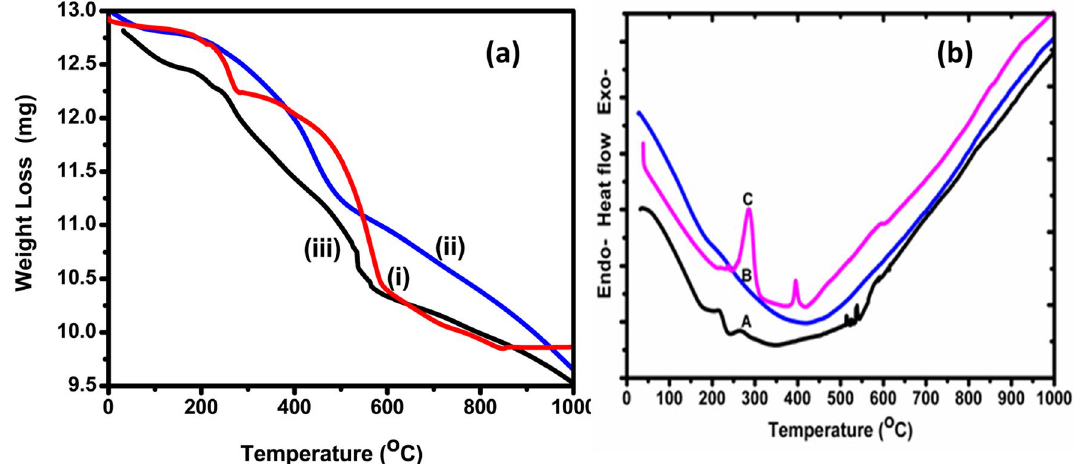
Figure 8. ( a ) Thermogram and ( b ) DTA curves of ( a ) pure TANI, ( b ) TANI/Cu 2 O and ( c ) TANI/Cu 2 O/Ag